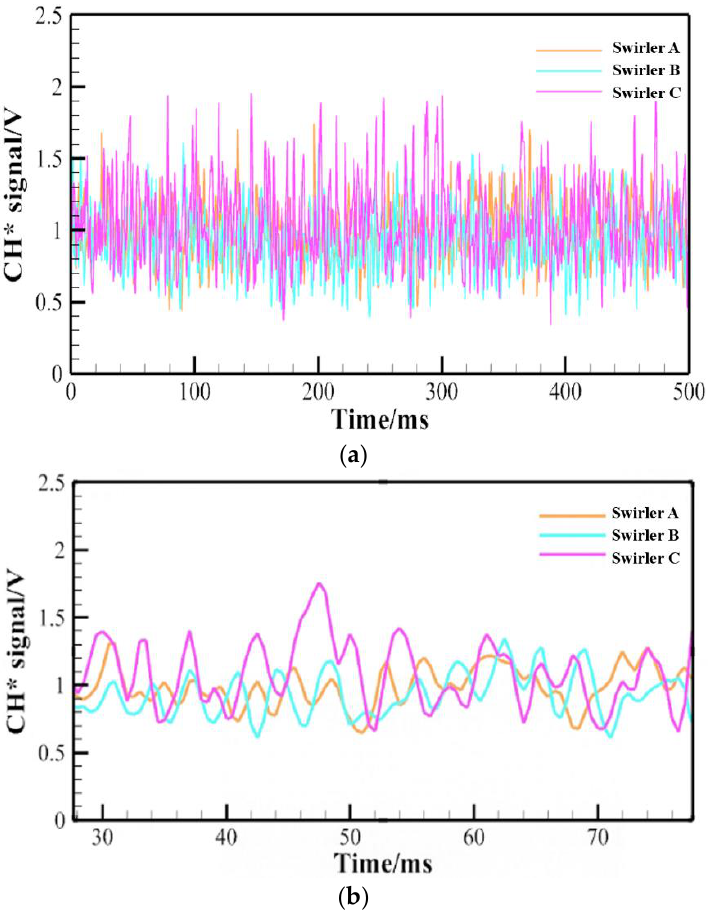
Figure 11. CH* signal in combustor under different swirler schemes ( a , b